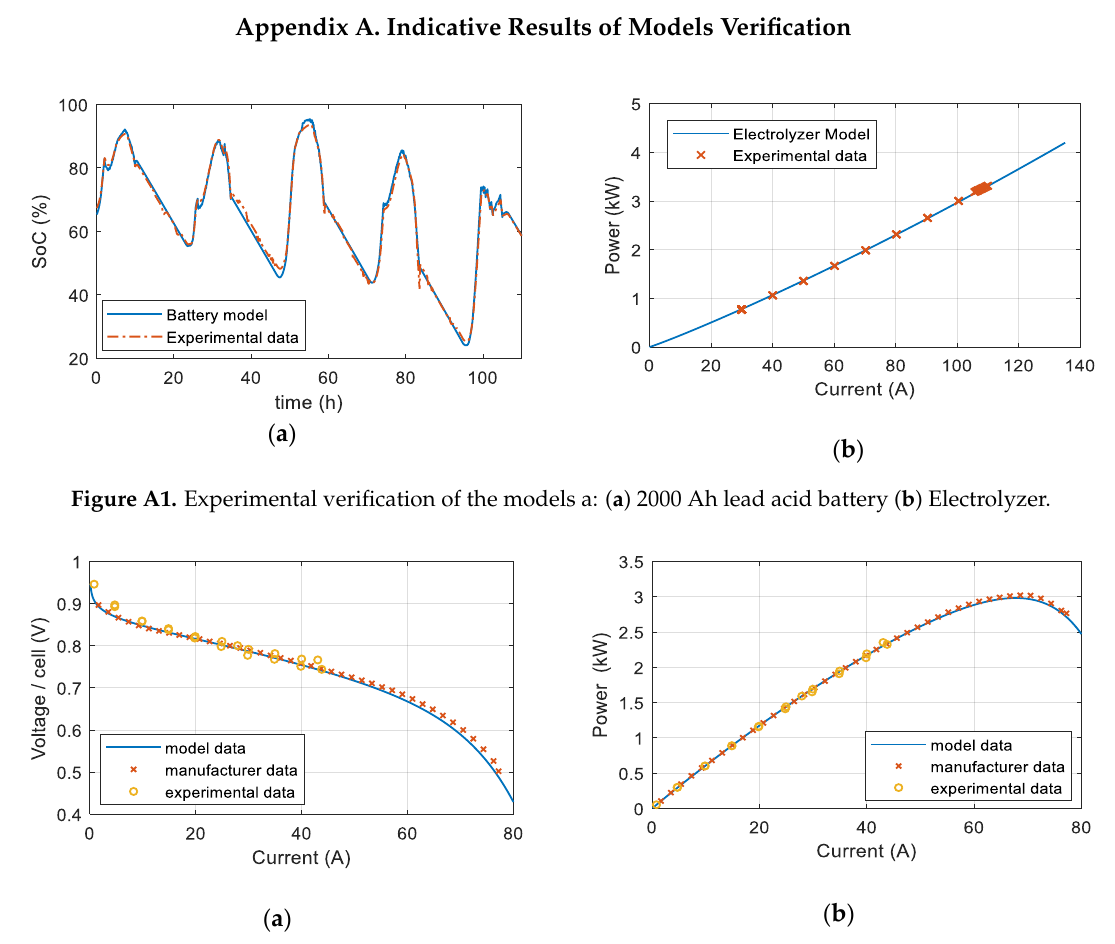
Figure A2. Experimental verification of the Fuel Cell’s model: ( a ) V-I current curve, ( b ) P-I curve.